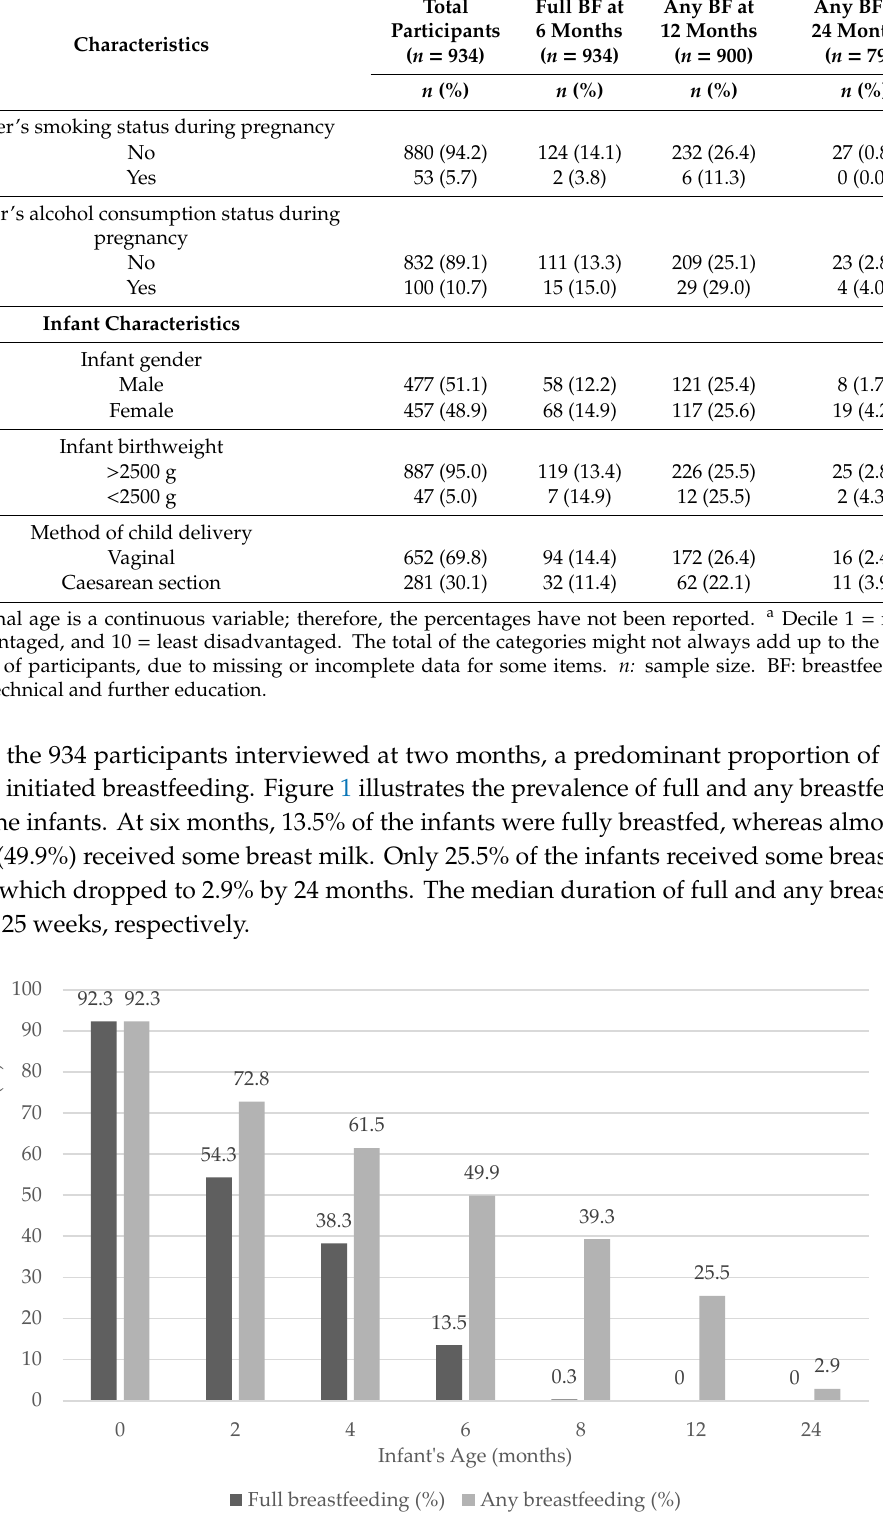
Figure 1. Prevalence of full and any breastfeeding by infant age.